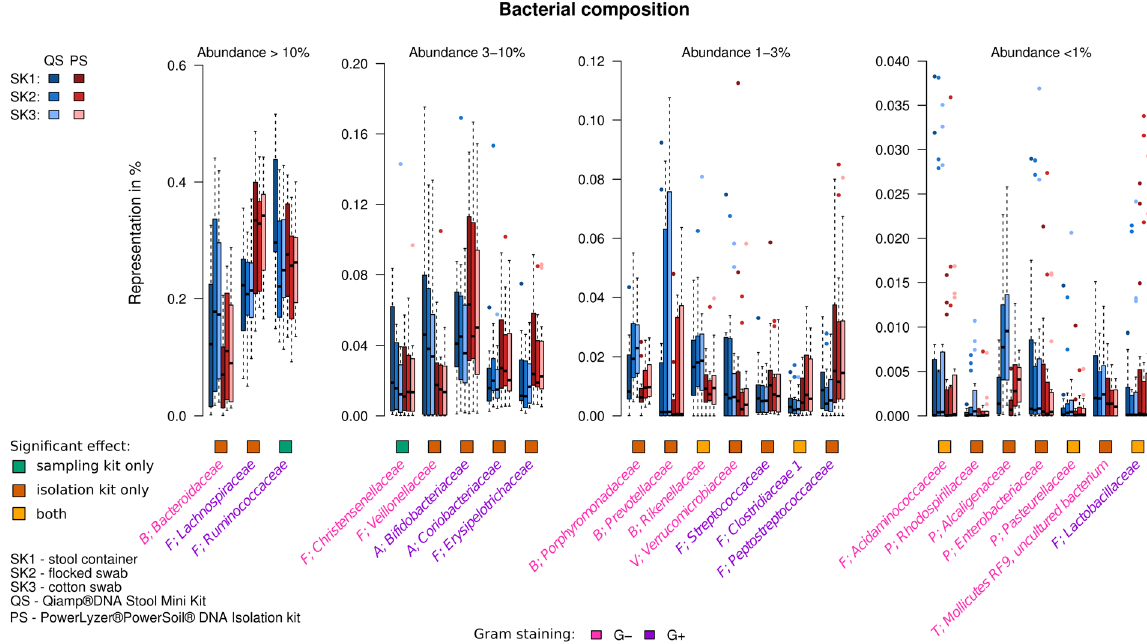
Figure 3. Distributions of relative abundances of significantly affected taxa at family level. Four graphs represent families divided according to third quartile of their abundance. Only taxa that passed the filtering criteria (maximum abundance > 1%), significantly affected by isolation or sampling kit are shown. The colored squares below the graph indicate whether the family was affected significantly by the sampling kit only, the isolation kit only or both.